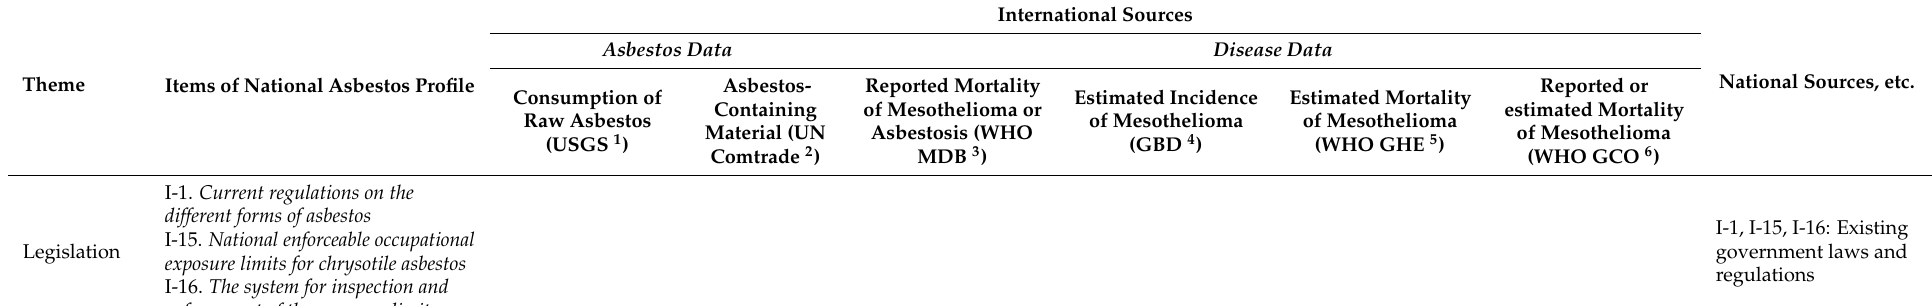
Table A3. Availability of Data in International and National Sources in Relation to Each NAP